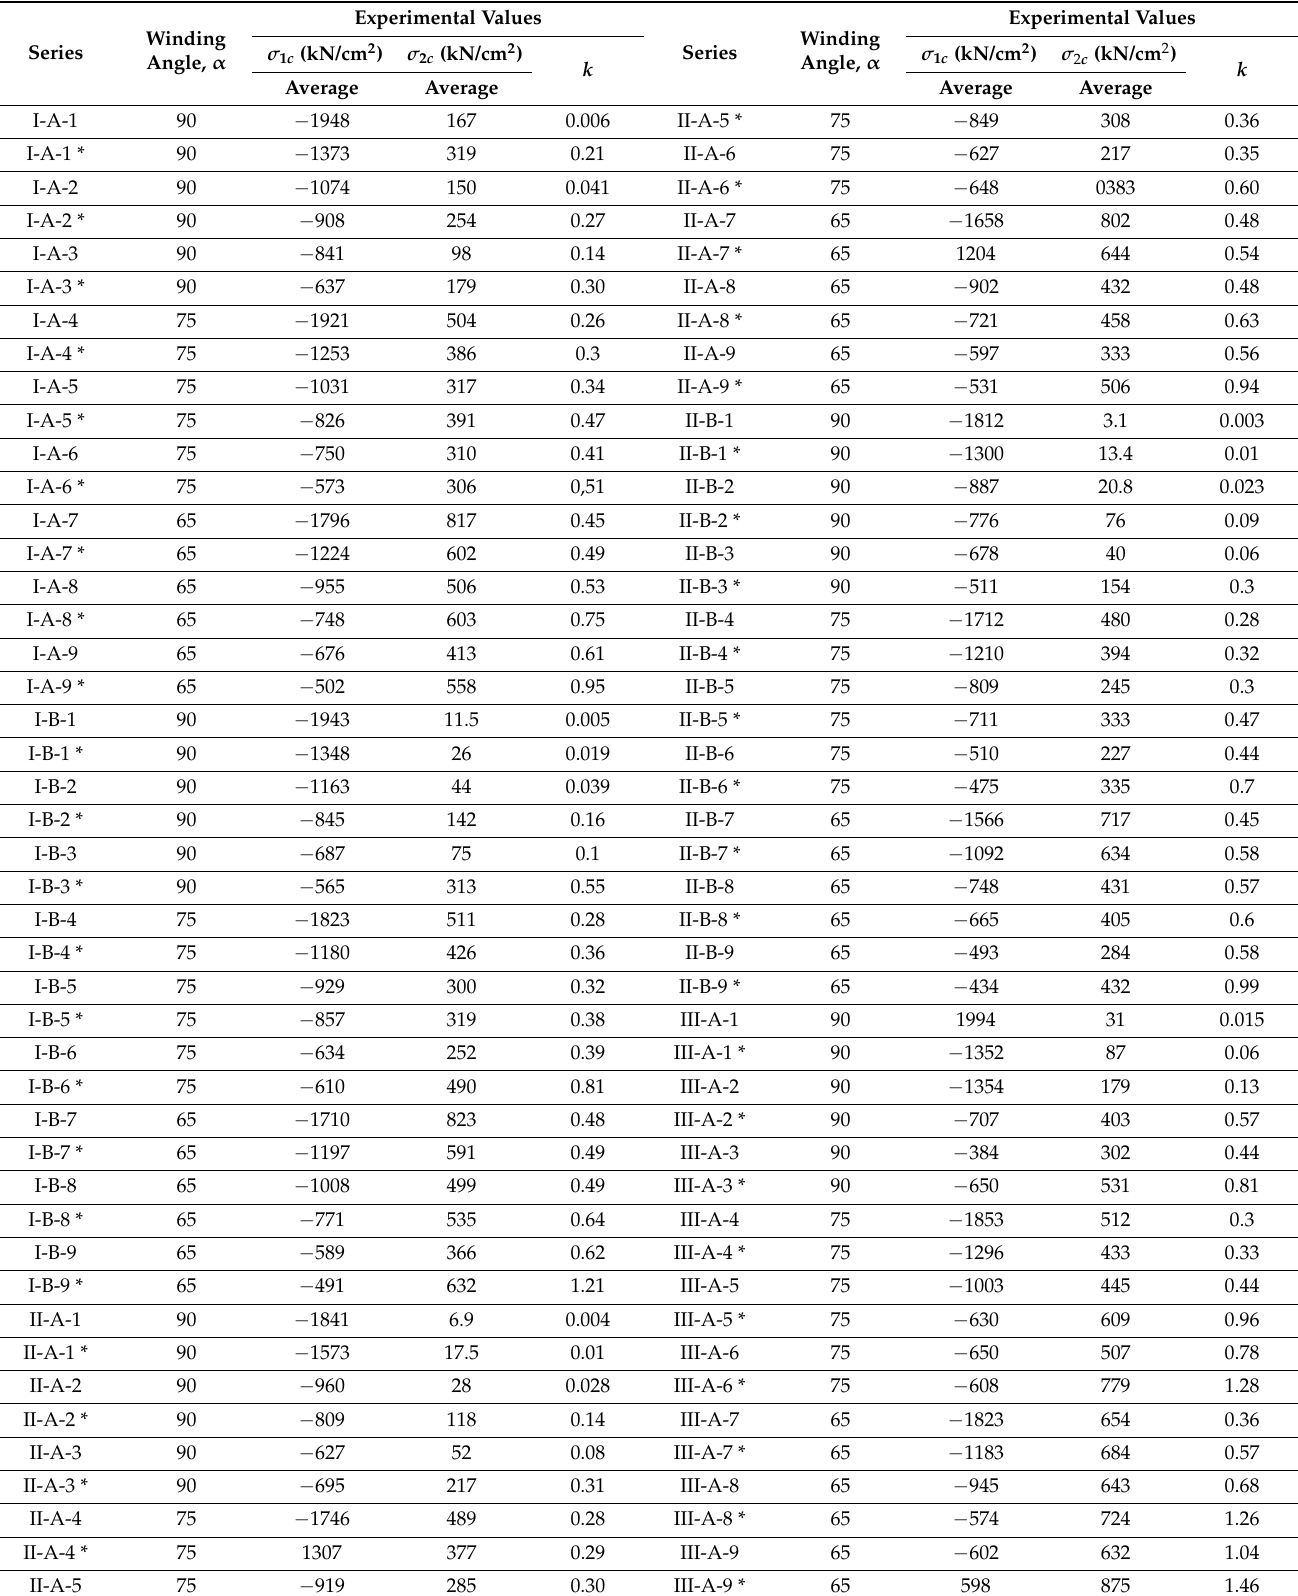
Table 2. Experimental data on the axial and circumferential stresses of the prestressed shell